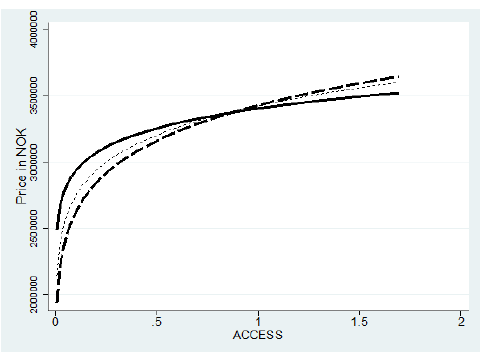
Figure 6: Predicted house prices of a standard